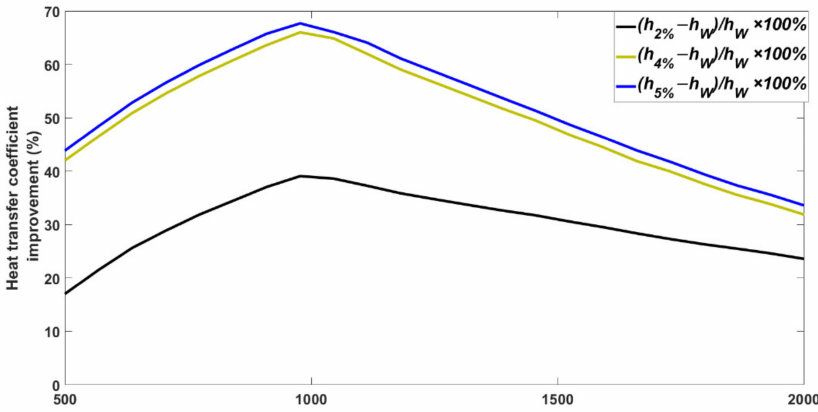
Figure 2. Contour plot of heat transfer coefficient versus volume fraction and Reynolds number for nanofluids flowing in cooling channels with 8 turns—results were obtained from 20 simulations.